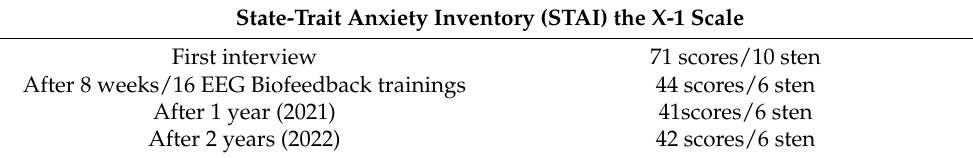
Table 4. Baseline and follow-up scoring of anxiety in study subject during the prolonged observation of the treatment